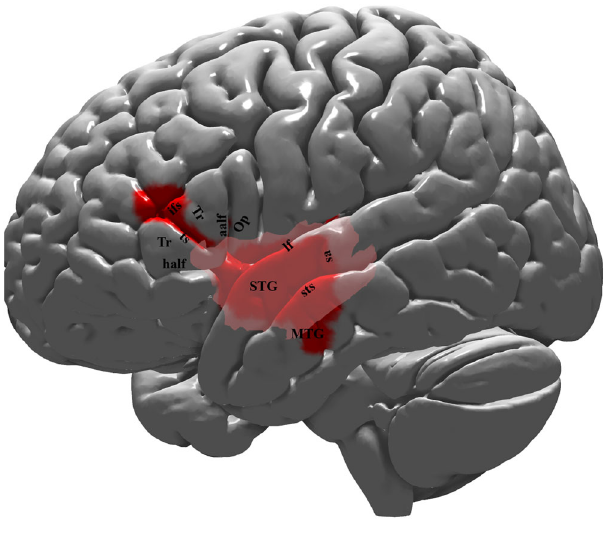
Fig. 2 Lateral view of the left hemisphere lesion of the patient with damage to the ventral language network (patient AA). The cortical lesion is marked by the red color and occupies the superior and middle temporal gyri (STG and MTG) anterior to the sulcus acousticus (sa), as well as the pars triangularis (area 45) of the inferior frontal gyrus. Note that the posterior parts of the superior and middle temporal gyri (i.e. the classical Wernicke area) and also the cortex of the pars opercularis (area 44) are spared. Thus, the lesion is restricted to the ventral language stream. Subcortically, the lesion is represented by the pale pink color. The lesion of the patient was reconstructed in MNI stereotaxic space and projected on the standard average MNI brain 65,66 . Abbreviations: aalf ascending anterior ramus of the lateral fi ssure; half horizontal ascending ramus of the lateral fi ssure; ifs inferior frontal sulcus; lf lateral fi ssure; MTG middle temporal gyrus; Op pars opercularis (area 44); sa sulcus acousticus; STG superior temporal gyrus; sts superior temporal sulcus; Tr pars triangularis (area 45); ts triangular